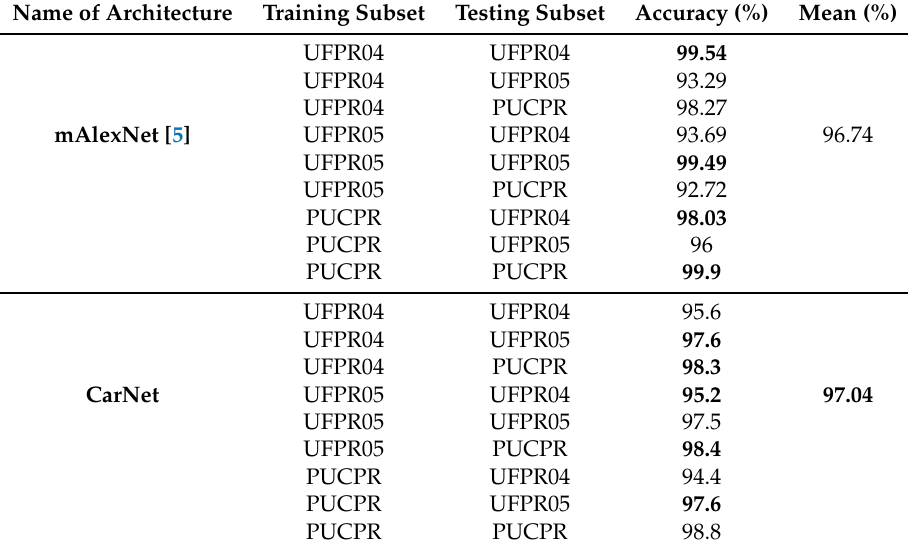
Table 13. Comparison of testing results of CarNet and mAlexNet [5] on PKLot dataset [4].